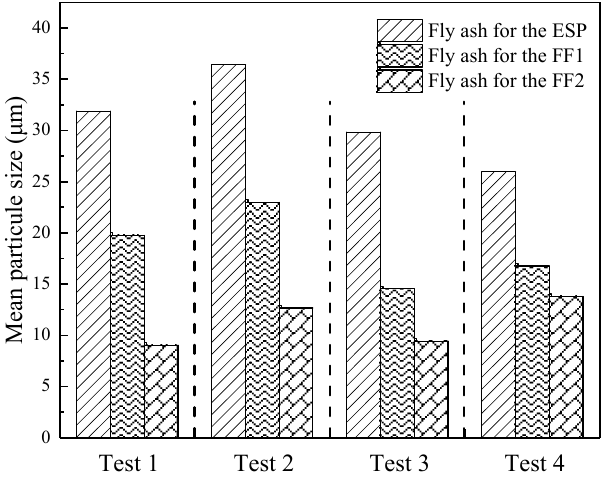
Figure 9. Particle-size distribution of the fly ash samples collected from the ESP, FF1 and FF2.